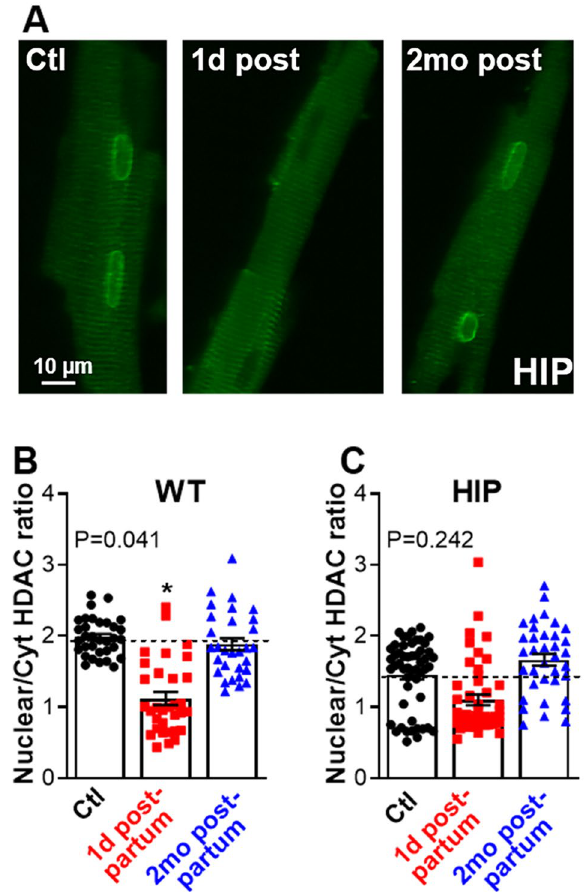
Figure 5. Nuclear versus cytosolic localization of HDAC4 in myocytes from HIP and WT females. ( A ) Examples of immunofluorescence images in myocytes from HIP females in the control (Ctl), 1 day postpartum (1d post) and 2 months postpartum (2mo post) groups. Cells were labeled with an anti-HDAC antibody. ( B,C ) Mean ratio of nuclear to cytosolic signal in cells from WT ( B ) and HIP ( C ) females in the control (WT: 3 females, 10–12 cells/rat; HIP: 5 females, 9–12 cells/rat), 1 day postpartum (WT: 3 females, 10–12 cells/rat; HIP: 4 females, 9–12 cells/rat) and 2 months postpartum (WT: 3 females, 10–11 cells/rat; HIP: 4 females, 6–10 cells/rat) groups. The number of cells per each rat is shown in Supplementary Table 3. Data for animals in control groups sacrificed at the time when pregnancy groups were at 1 day and 2 months postpartum were pooled. Statistical analysis was performed with a mixed model using the Nested One-Way ANOVA analysis in Prism 8.1.2 and Dunnett’s post-test for multiple